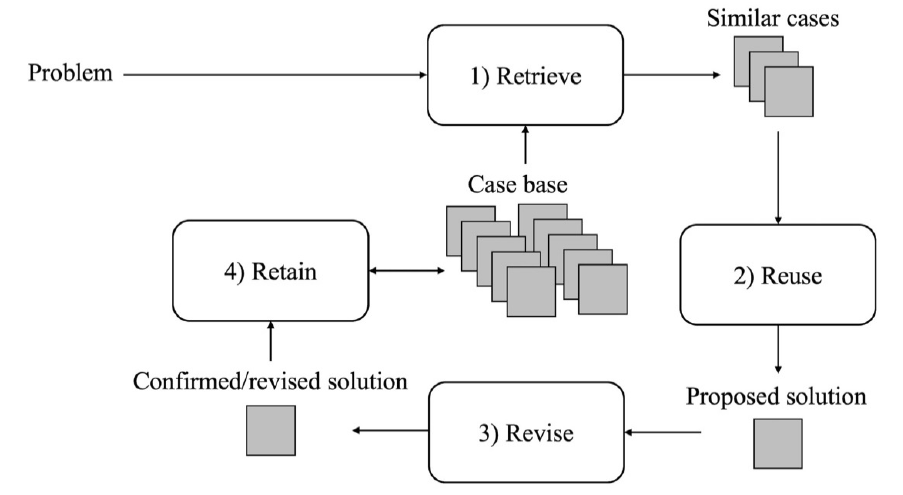
Figure 3. Schematic representation of the CBR cycle proposed by Aamodt and Plaza [43]. The R2R+CBR algorithm was first tested in simulation and compared with the stand-alone R2R algorithm. A scenario of one-month duration, including patient behaviour and physiological variability was generated using the UVa/Padova T1D Simulator [38]. The results obtained in a cohort of 20 virtual subjects showed that the adoption of R2R+CBR significantly improved glycemic control, achieving better results than the stand-alone R2R algorithm. The proposed R2R+CBR algorithm was able to tackle intrasubject variability and external perturbations, and it was shown to be robust to uncertainty in carbohydrate input (i.e., carb-counting error) and noise in CGM measurements. The R2R+CBR algorithm has been implemented in the so-called Advanced Bolus Calculator for Diabetes (ABC4D) [44], which is a novel BC for personalized insulin recommendations for people with T1D. ABC4D was tested in a six-week-long non-randomized clinical study, involving 10 adult